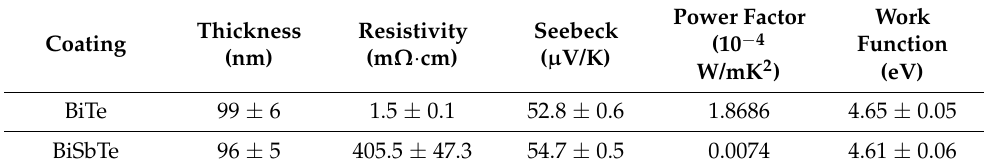
Table 3. Thickness, resistivity, Seebeck, and power factors for BiTe and BiSbTe semiconductors deposited for 3 and 15